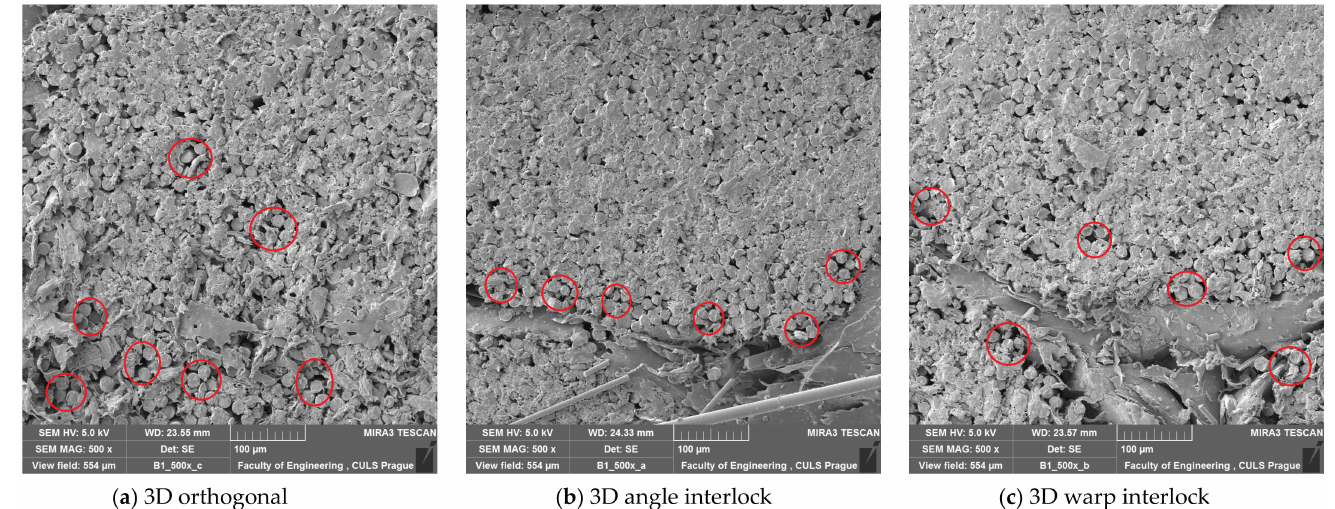
Figure 11. SEM images of tensile tested 3D woven composite samples prepared at 12 bar molding pressure.